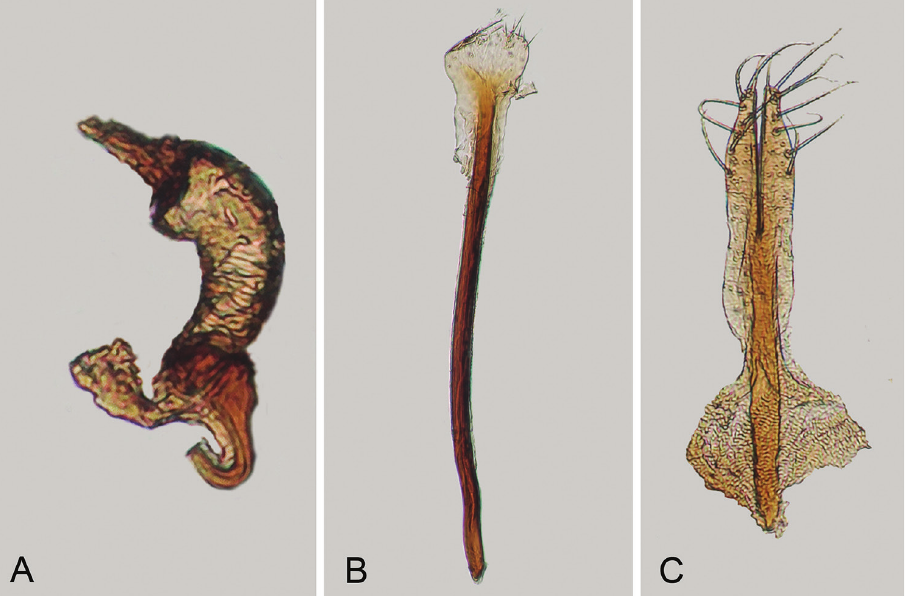
Figure 18. Andersonoplatus macubaji . A Spermatheca B Tignum C Vaginal palpi. each other, receptacle longer than pump. Apex of pump with spoon-like projection relatively thick at base. Spermathecal duct short, widest at base, without coils, making narrow loop (Fig.